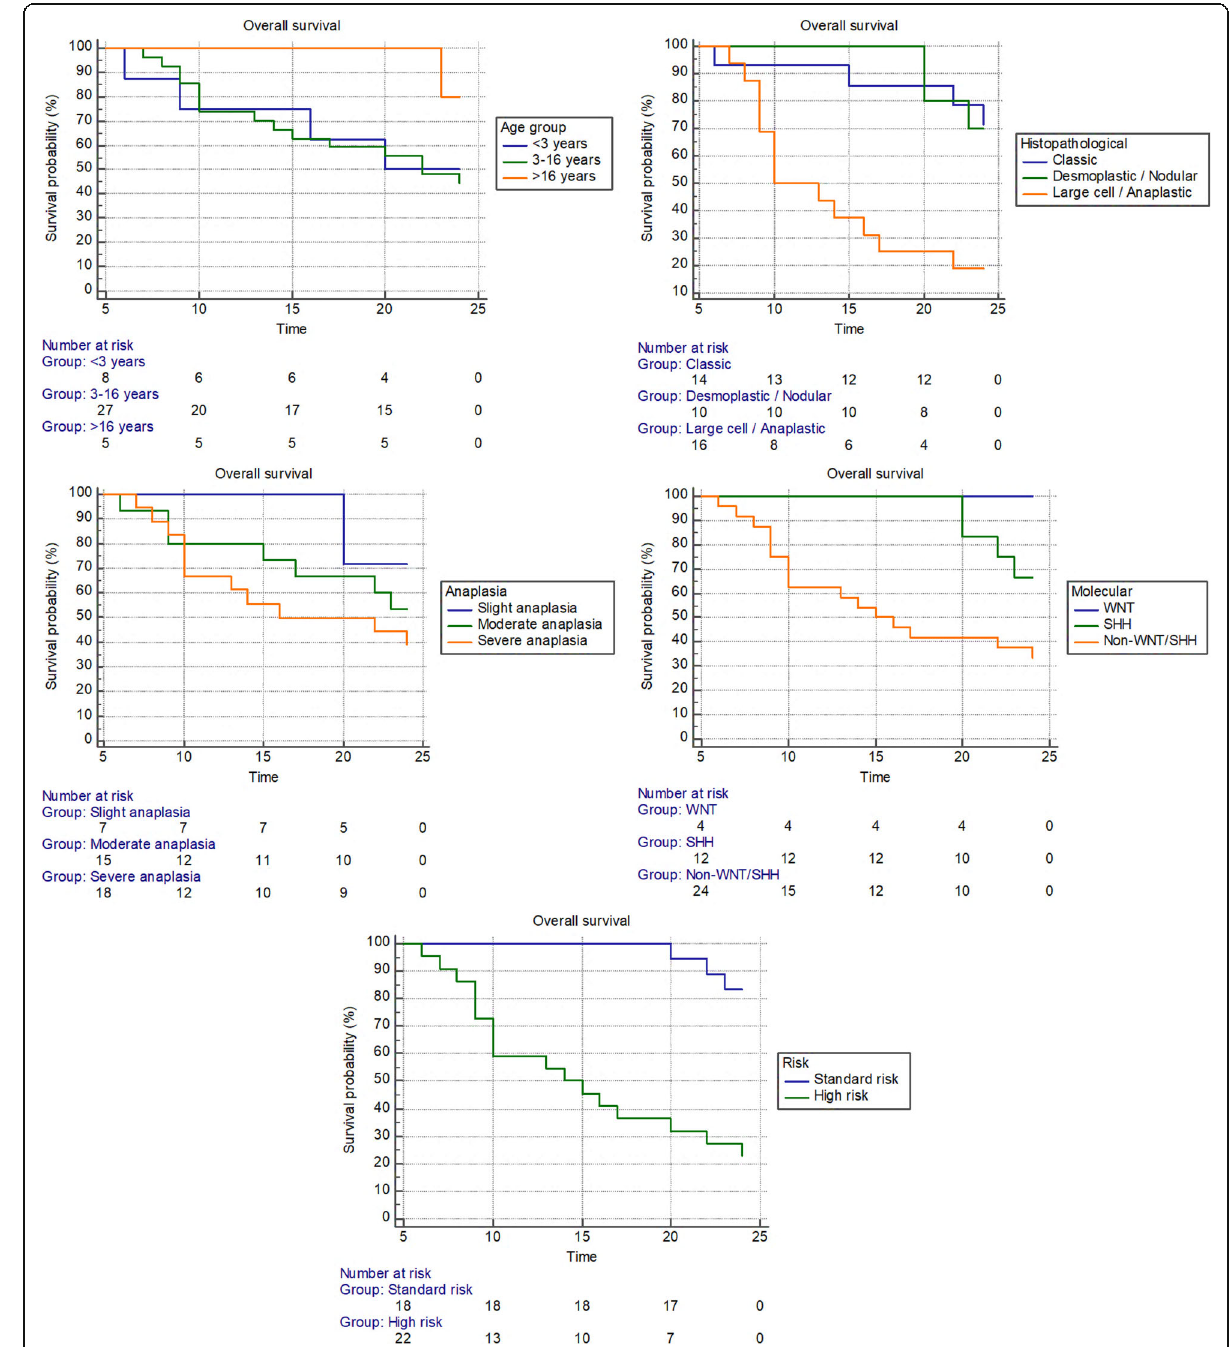
Fig. 3 Kaplan-Meier curves for overall patients ’ survival (OS), in relation to age group, histopathological types, degree of anaplasia, molecular subgroups, and risk